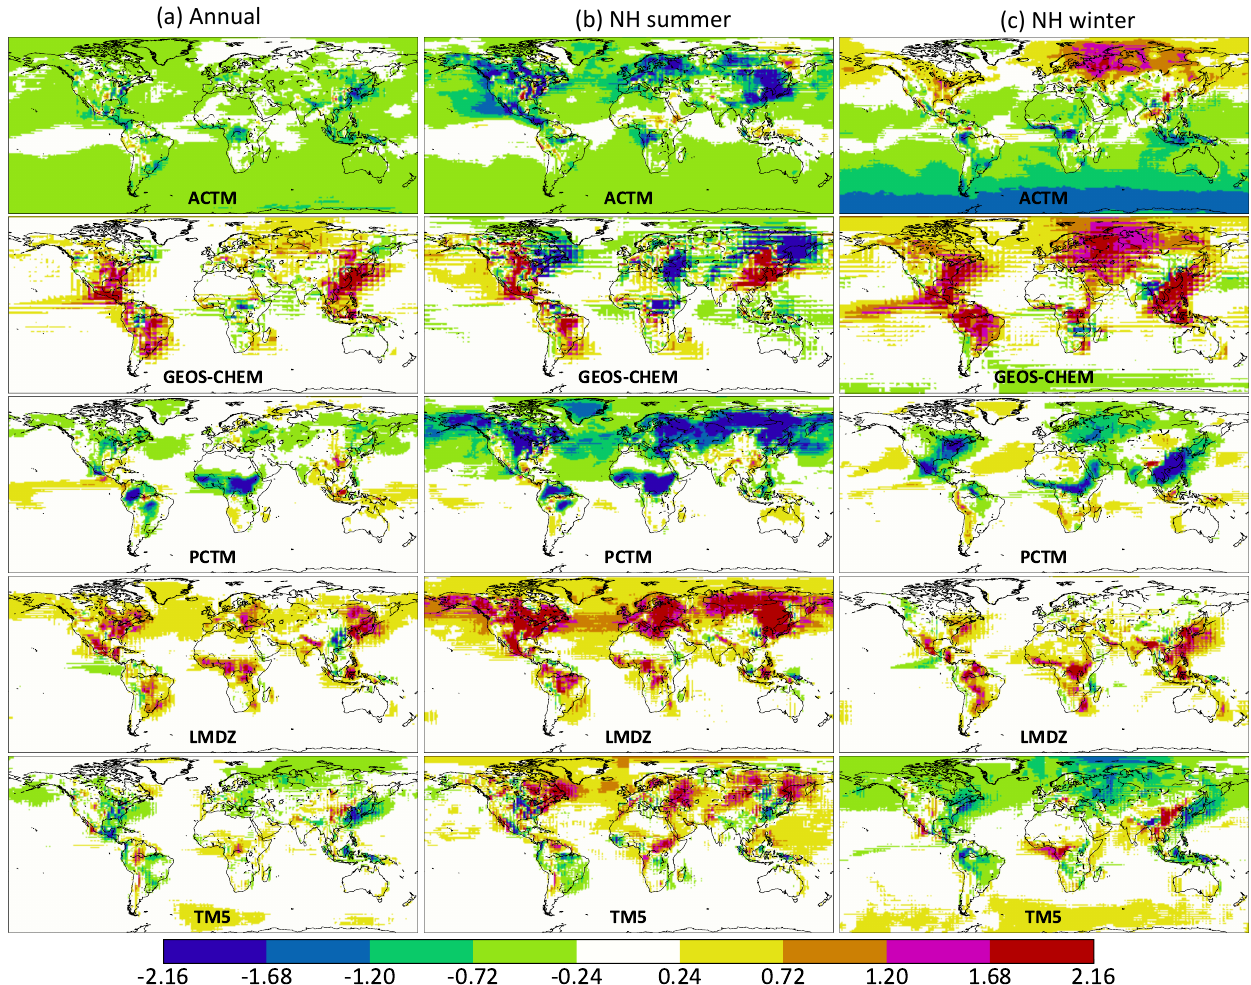
Figure B1. The difference between each model (ACTM, LMDZ, GEOS Chem, PCTM and TM5) and the cross-model median at 13:30 local time in the lowest 150hPa, which is an approximation for the planetary boundary layer (PBL). (a) shows the difference averaged over all of 2015, (b) is averaged over Northern Hemisphere summer months (June–August 2015) and (c) is averaged over Northern Hemisphere winter months (December 2015 to February 2016). Differences are shown in ppm CO 2